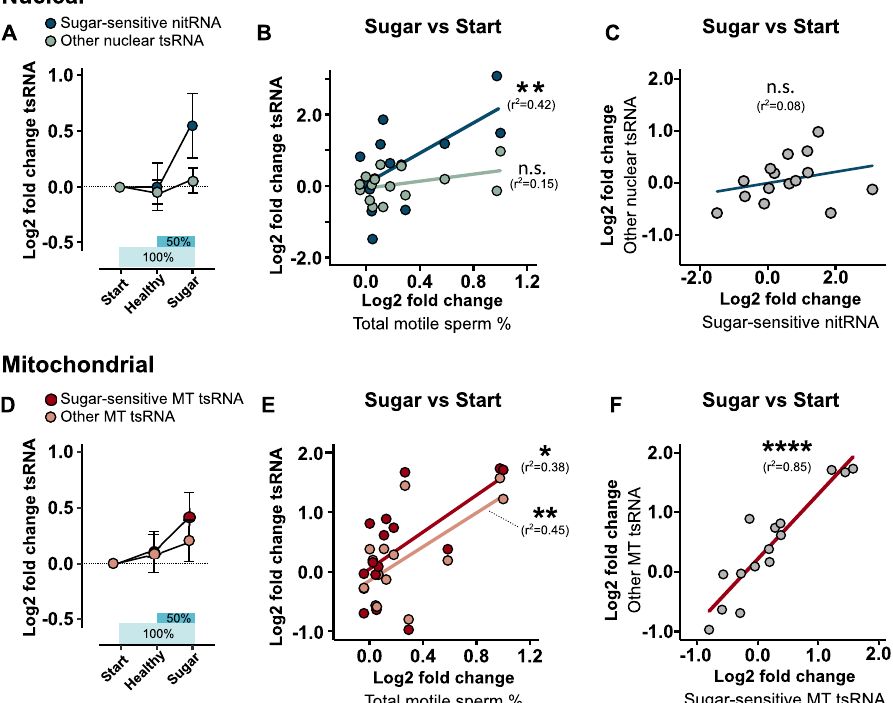
Fig 6. Sperm motility is positively associated with parallel changes in tsRNA. Nuclear and MT tsRNA—either sugar-sensitive (= significantly up-regulated in Sugar versus Healthy) or other (= not significantly up-regulated tsRNA) —were reevaluated in relation to Start point values. (A) Shows the changes in nuclear sugar-sensitive nitRNA (dark points) and other nuclear tsRNA (light points) over the whole diet intervention. Note that sugar-sensitive nitRNA specifically responded to Sugar. (B) Changes in sperm motility between Sugar versus Start diets were associated with sugar-sensitive nitRNA (dark points), but not other nuclear tsRNA (light points). (C) No association between changes in nitRNA and other nuclear tsRNA. (D) Changes in sugar-sensitive MT tsRNA (dark points) and other MT tsRNA (light points) in relation to Start point values. Note that all MT tsRNA progressively increased over the diet intervention, but a boost was seen in sugar-sensitive after Sugar. (E) Changes in both sugar-sensitive MT tsRNA (dark points) and other MT tsRNA (light points) were associated with changes in sperm motility. (F) Changes in sugar- sensitive MT tsRNA and other MT tsRNA were strongly correlated. ���� p < 0.0001, �� p < 0.01, � p < 0.05, # p < 0.1. Data are available in S2 Table (sperm motility) and S2 Data (tsRNA). Healthy, samples taken after healthy diet; MT, mitochondrial; nitRNA, nuclear internal T-loop tsRNA; n.s., not significant; Start, start point samples; Sugar, samples taken after high-sugar diet; tsRNA, tRNA-derived small